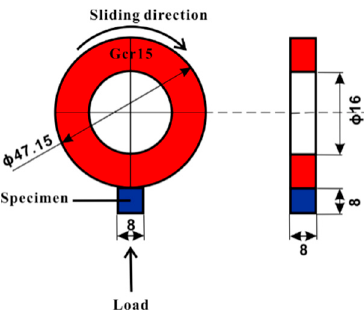
Figure 1. A schematic showing the wear test configuration including the position of the specimen, sliding direction and dimensions of the